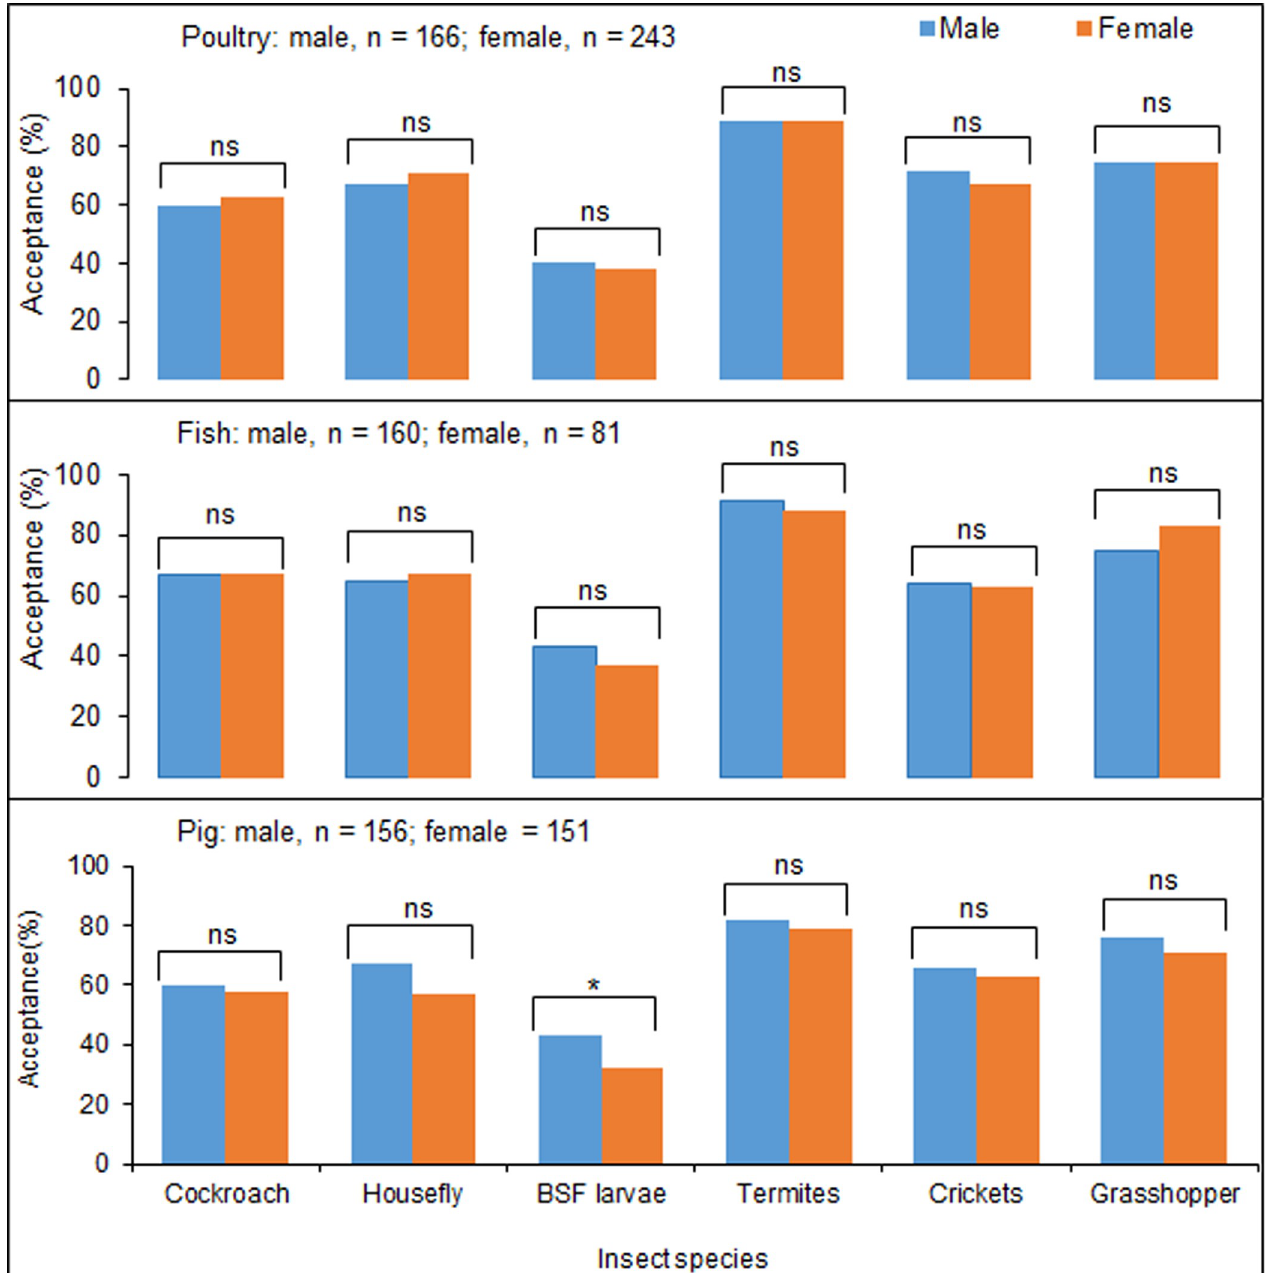
Fig 2. Percentage farmers that accept insects as feed ingredients among poultry, fish and pig farmers. Bars with an asterisk are significantly different for male and female respondents, P < 0.05, two-proportion z-test. Bars with “ns” are not significantly different for male and female respondents, P < 0.05, two- proportion z-test. BSF = black soldier fly. For additional statistical analyses see Table